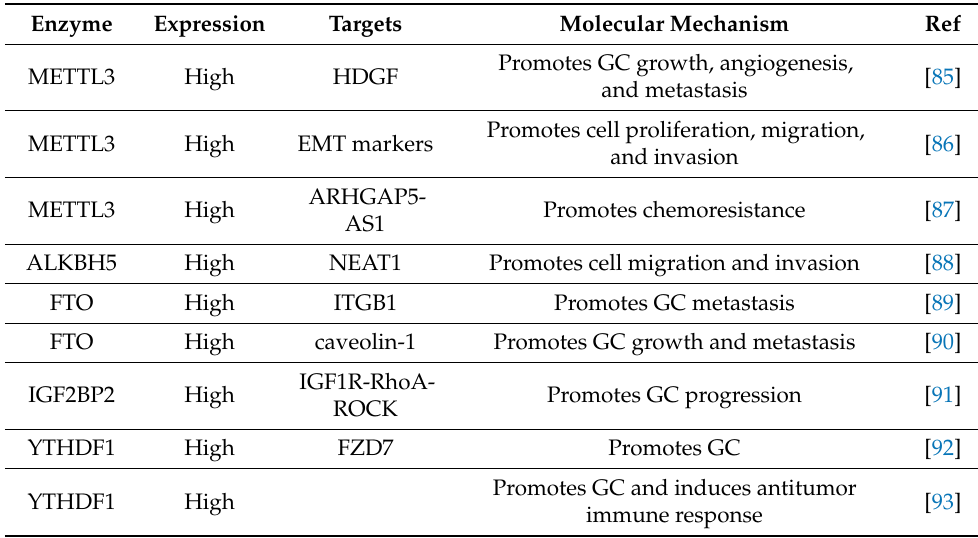
Table 3. RNA modification and gastric